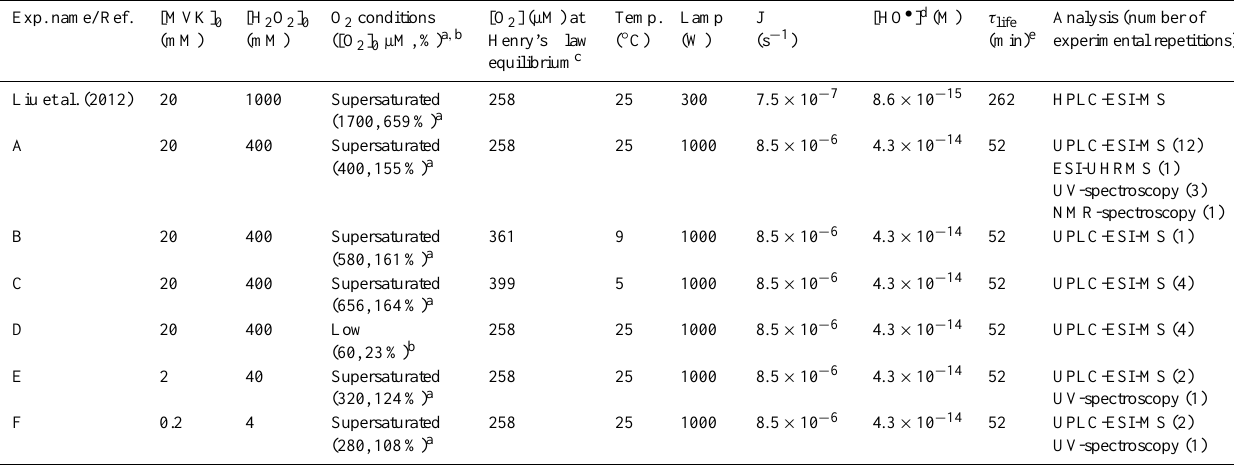
Table 1. Experimental conditions of OH-oxidation of MVK, and comparison with our previous work, the study by Liu et al. (2012). In all studies, all experiments were unbuffered (free